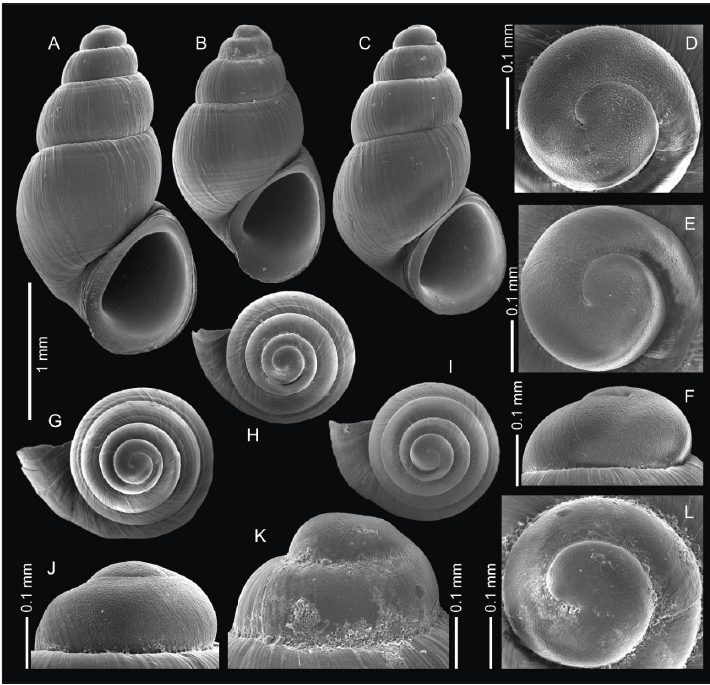
edge of the rachidian tooth, there are four lateral cusps on each side of the median cusp (4 – 1 – 4: Figure 8A – C), which is much larger than the lateral cusps and is triangular in shape. Two to three sub-basal cusps are well-developed on each side of the basal plate of the rachidian tooth. The lateral tooth formula is 3 – 1 – 3(4); the biggest cusp is long and massive (Figure 8B,C). On the inner marginal tooth, there are about 15 – 16 cusps, their length diminishing gradually from the long and slender distal cusps. The outer marginal tooth bears up to 23 long and slender cusps, their size gradually decreasing from the cen- tral part (Figure 8C, Table 6). Soft body and the reproductive anatomy . The snout and the body are faintly brown or almost unpigmented (Figure 9A,B); the ctenidium is lying in the middle part of the mantle cavity; a large osphradium is located in the middle of the gill with 12 – 14 triangular Figure 7. Clathrocaspia laevigata sp. n. shell morphology: ( A , D , G , J ) — paratype, IZAN 612/1, loc. Figure 7. Clathrocaspia laevigata sp. n. shell morphology: ( A , D , G , J )—paratype, IZAN 612/1, loc. leaflets (n = 4). Dag28 (the same individual as Figure 4I); ( B , H , K , L ) — paratype, IZAN 613/3, loc. Dag32 (the same The penis is non-pigmented, colorless or light yellow, blunt, and broad; its base lies individual as Figure 4M); ( C , E , F , I ) — specimen IZAN 612/3, loc. Dag28. Dag28 (the same individual as Figure 4I); ( B , H , K , L )—paratype, IZAN 613/3, loc. Dag32 (the same behind the left tentacle; in adults, it is bent towards the opening of the mantle cavity. The individual as Figure 4M); ( C , E , F , I )—specimen IZAN 612/3, loc. Dag28. vas deferens runs approximately in the center of the penis or slightly closer to its base and Table 2. The morphometric characteristics of shells of the Clathrocaspia species discussed in this opens at a pointed protrusion (Figure 9D,E,K). study. Above lines — min – max values; below lines — mean value ± SD. Abbreviations according to Figure 3.